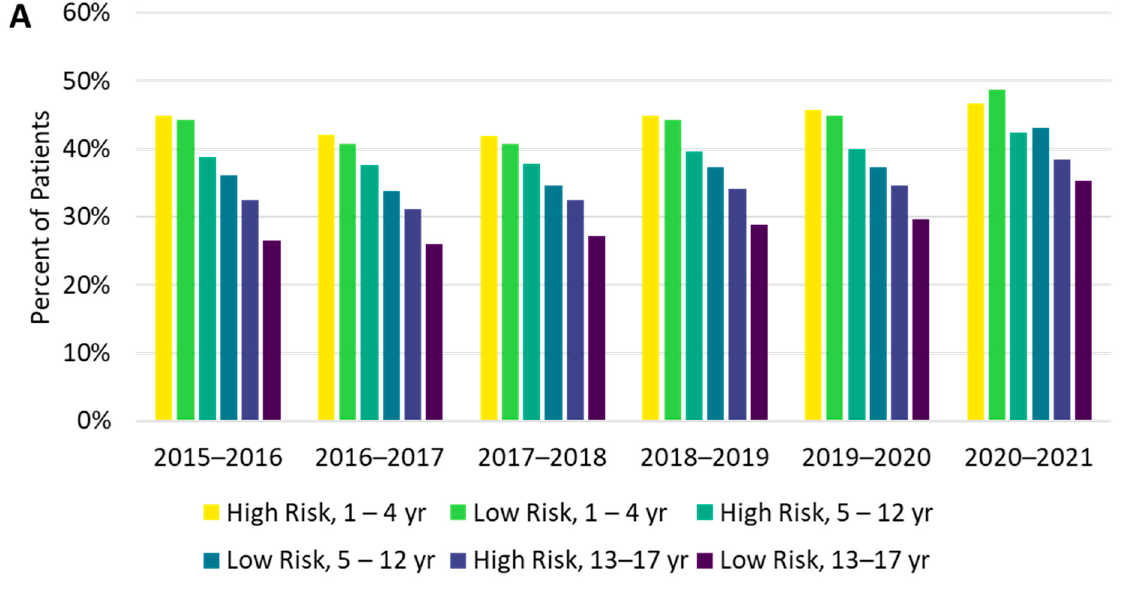
Figure 3. Vaccine uptake from the 2015–2016 through the 2020–2021 influenza seasons by risk and age group for individuals ( A ) 1–17 years of age and ( B ) 18 years and older. 3.3. Vaccination Timing and Settings October was the peak month for vaccinations in all influenza seasons (Figure S2a). In the 2020–2021 influenza season, 78.1% of vaccinated individuals received their influenza vaccinations between August and October (early vaccinations), compared with only 64.2% to 68.9% in the previous five seasons (Figure S2b). The proportion of patients identified as being vaccinated via pharmacy claims was highest in the 2020–2021 season (36.0%) and was consistent with the increasing trend of pharmacy influenza vaccine claims over the previous seasons (from 15.7% in 2016–2017 to 28.3% in 2019–2020). A concomitant decrease in office/outpatient-based administration was also observed across the seasons. However, it is possible that not all vaccinations identified via pharmacy claims were administered in a pharmacy. For example, a vaccine could have been dispensed from a pharmacy and administered at an outpatient clinic.